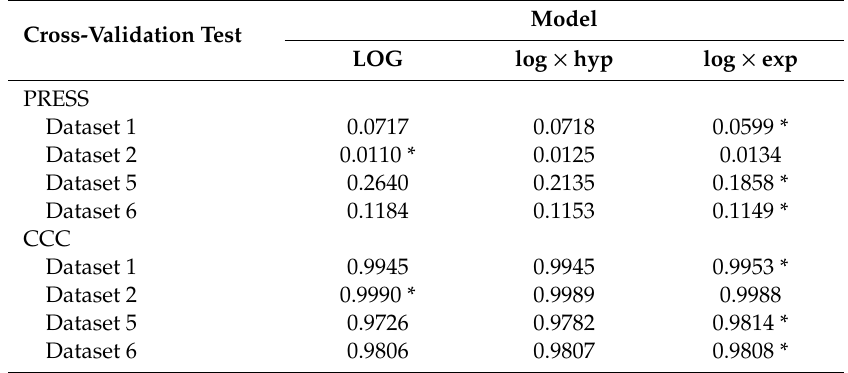
Table 5. Predicted residual error sum of squares (PRESS) and concordance correlation coe ffi cient (CCC) resulting from cross-validation of Datasets 1-2 from Study 1 and Datasets 5-6 from Study